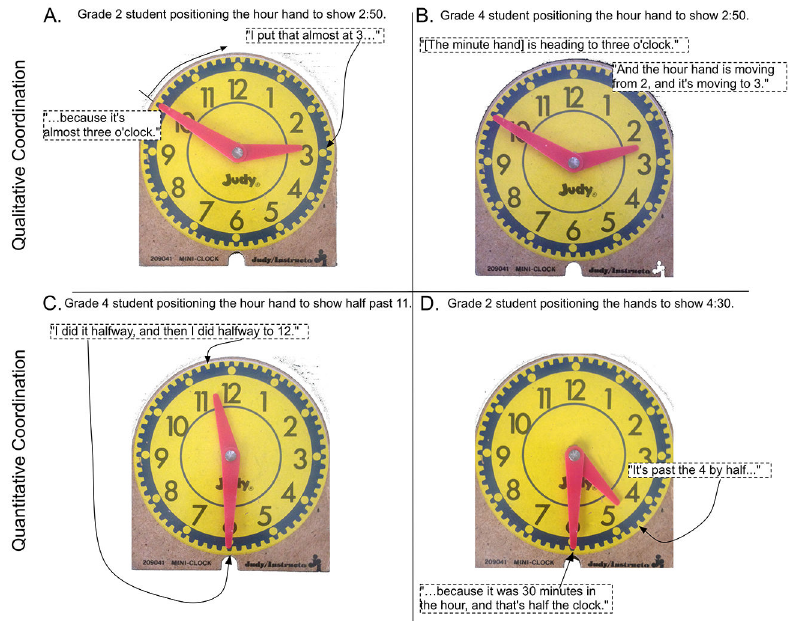
Figure 6. Students’ strategies to position hour and minute hands included: (a-b) Qualitative Coordination, and (c-d) Quantitative